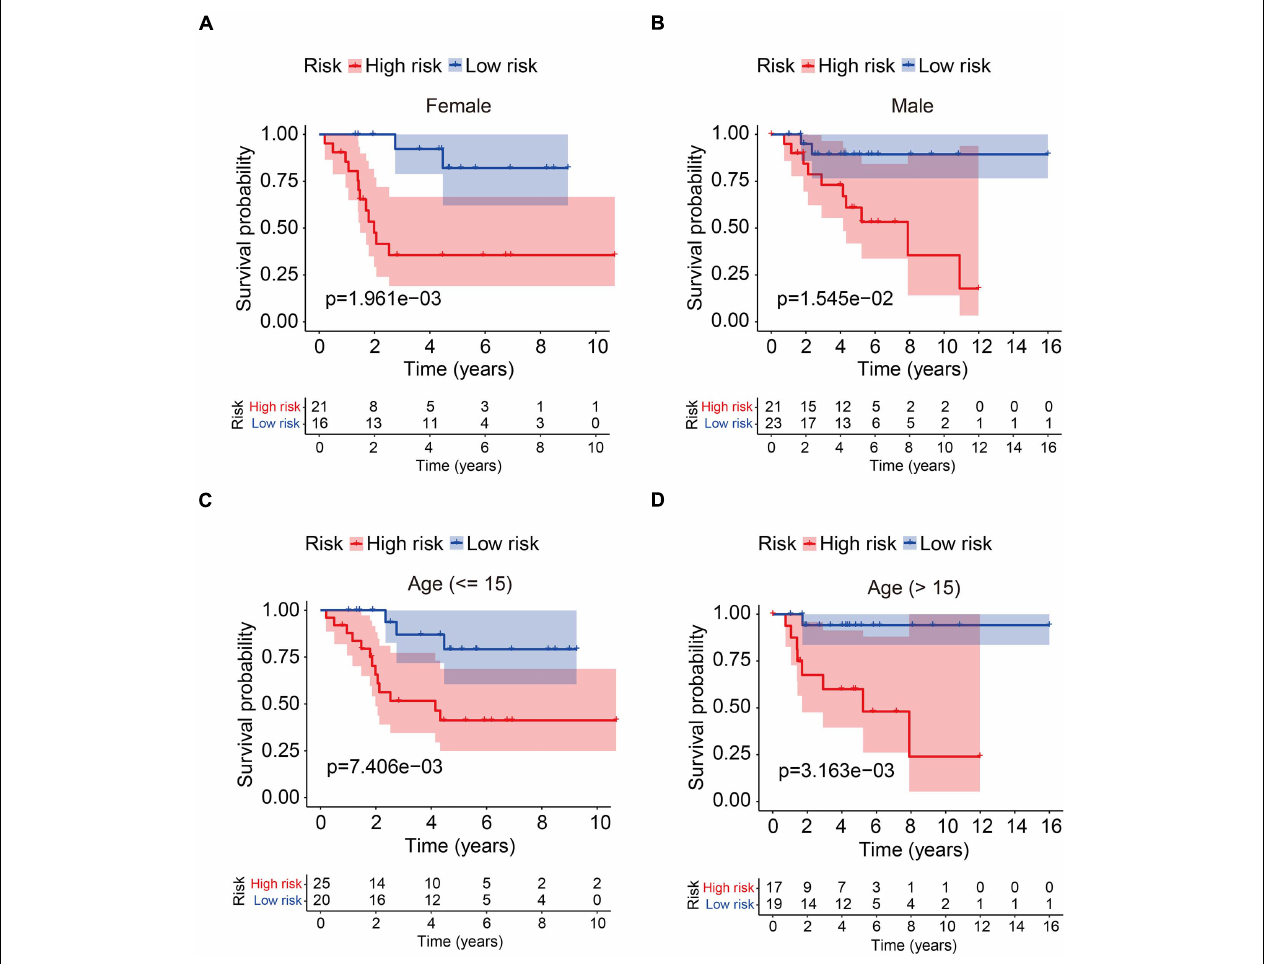
FIGURE 5 | Analysis of the six-MRG signature in clinicopathological subtypes of osteosarcoma. (A,B) Kaplan-Meier survival curve analysis of high- and low-risk males and females. (C,D) Kaplan-Meier survival curve analysis of high- and low-risk patients aged ≤ 15 or age > 15